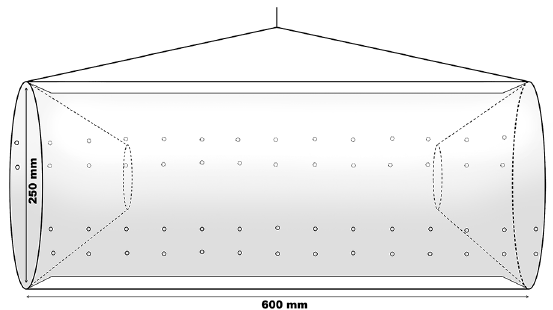
Figure 1 - Representation of the plastic trap used for collections of Macrobrachium amazonicum (Heller, 1862) at the studied